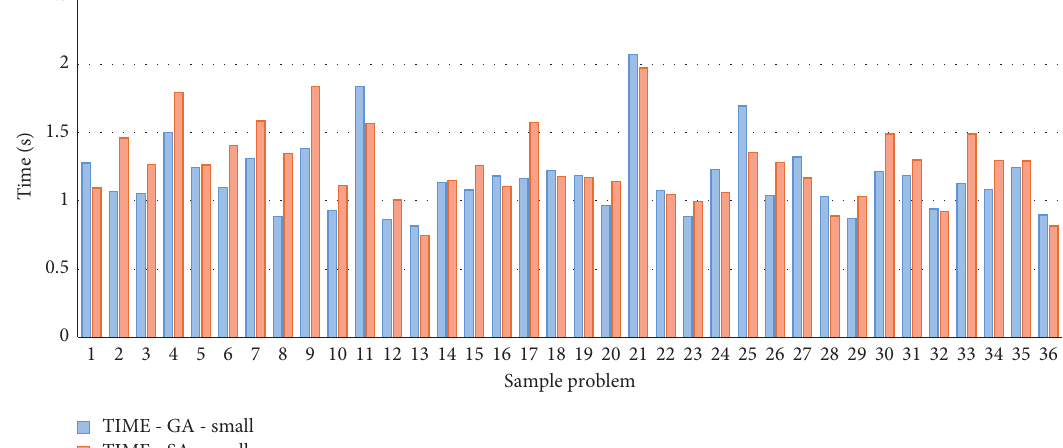
Figure 6: Comparison the outcomes of running time of small size algorithm between GA and SA algorithms.